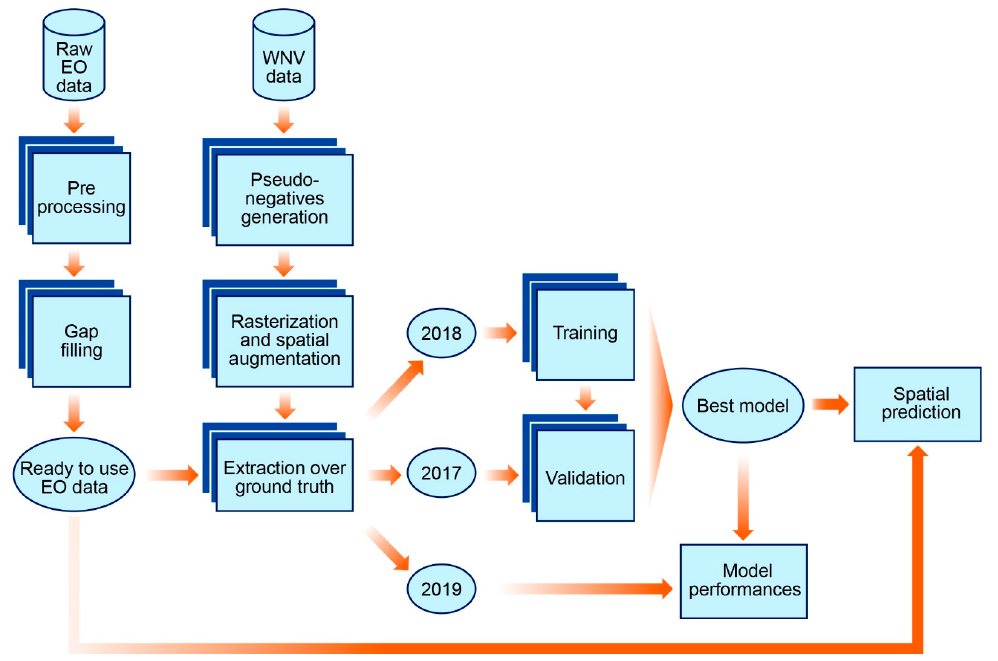
Figure 1. Flow chart of the process adopted to develop the predictive